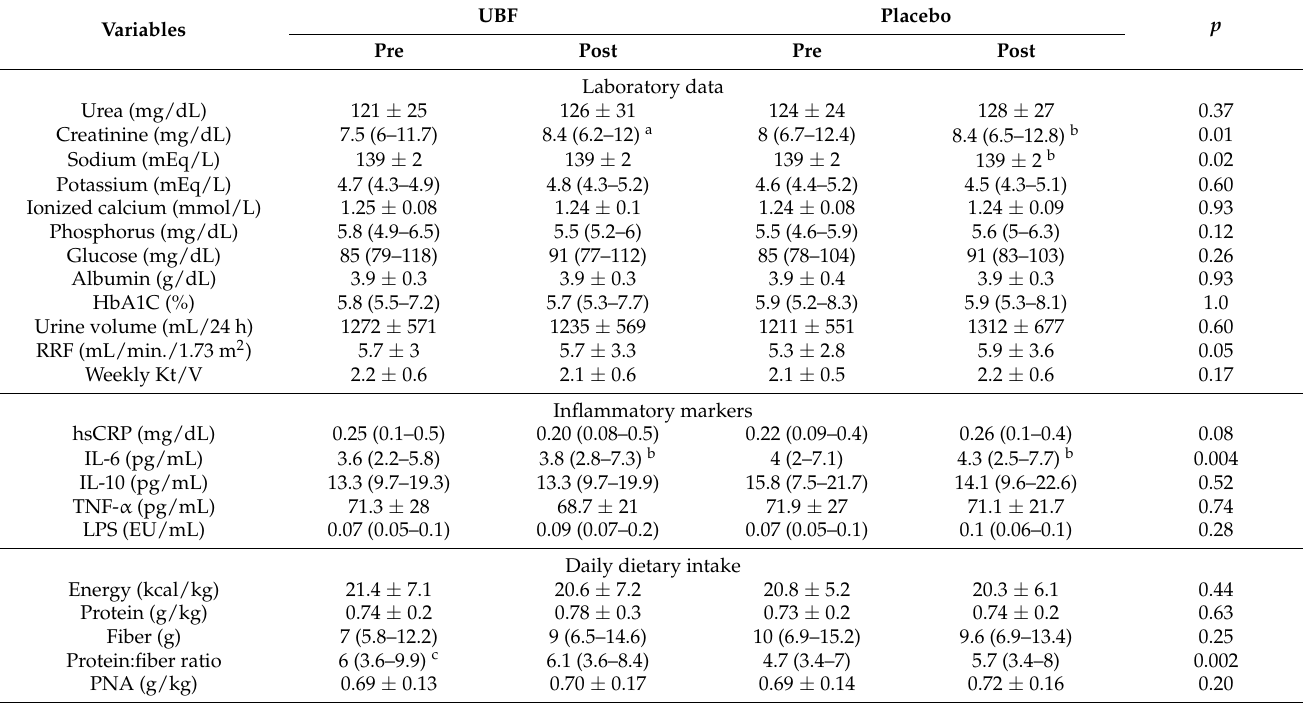
Table 2. Laboratory parameters and dietary intake according to UBF and placebo arms during the follow-up of patients undergoing peritoneal dialysis ( n = 26).